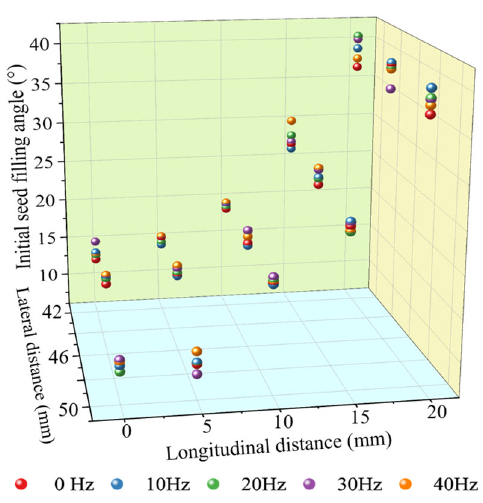
Figure 12. Effect of vibration on initial seed ‐ filling angle under different longitudinal and lateral distances . The established regression model of the seed ‐ filling angle was significant ( p < 0.01). As shown in Table 7, the seed ‐ filling angle was significantly influenced by frequency and longitudinal distance ( p < 0.01), and markedly affected by lateral distance ( p < 0.05). The seed ‐ filling angle significantly increased with an increase in the longitudinal distance, with the minimum at a longitudinal distance of 0 mm and a lateral distance of 50 mm, and the largest at a longitudinal distance of 20 mm and a lateral distance of 42 mm (Figure 13a–e). The seed ‐ filling angle affected by the longitudinal distance was greater than that affected by the lateral distance. The seed ‐ filling angle at 20–40 Hz was significantly greater than that at 0–10 Hz. A larger frequency vibration increased the shaking and compressive force of the rapeseeds, resulting in an increase in the seed ‐ filling angle.